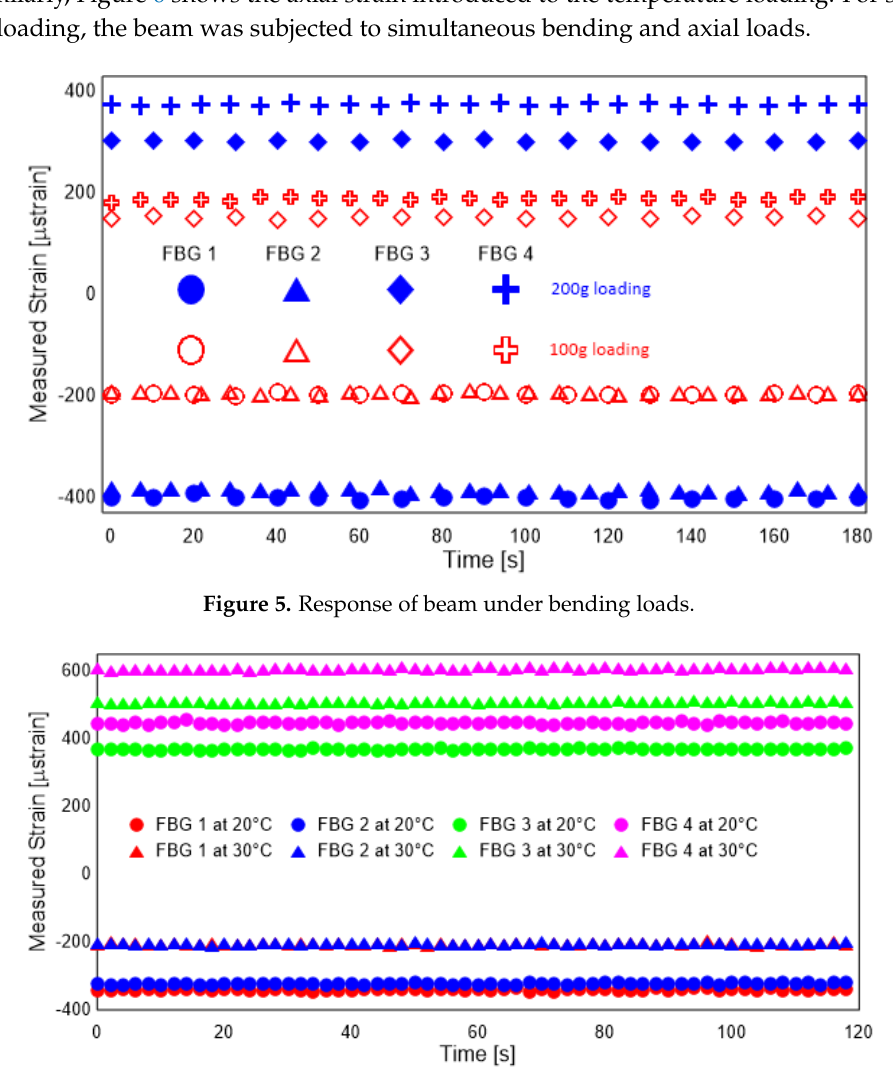
Figure 6. Response of beam under thermal (axial)